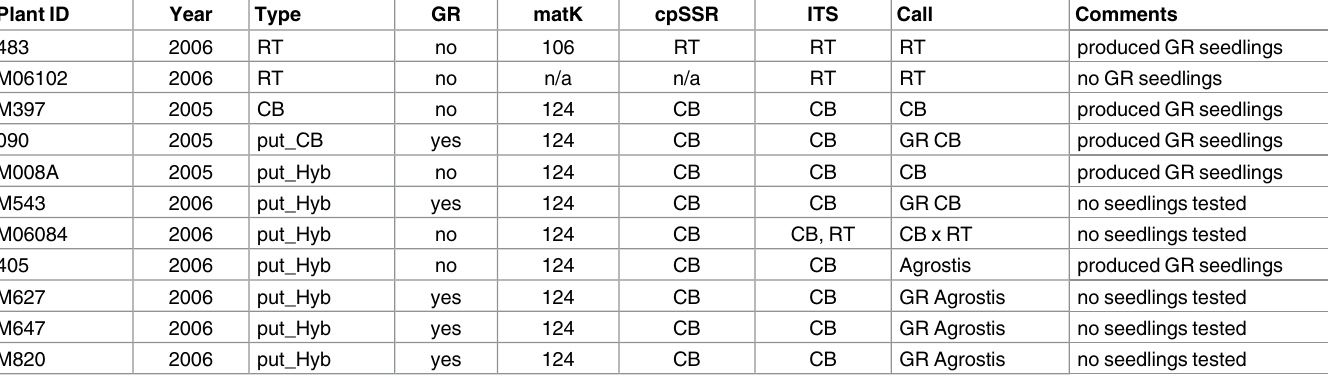
Table 4. Characteristics of plants established in situ . Plant ID (PlantID), year of identification (Year), type of plant basedon phenotype(Type), glypho- sate-resistance trait (GR), matK indel allele(matK), chloroplasthaplotype(cpSSR), ITS sequencetype (ITS), species/hybrid call basedon all information (Call), and comments.